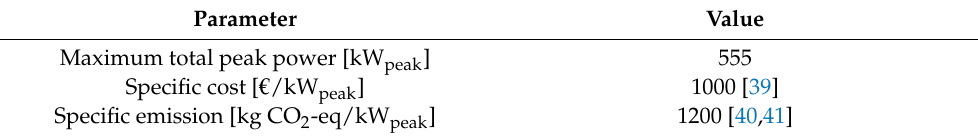
Table 3. Boundaries and specific parameter for photovoltaic systems.